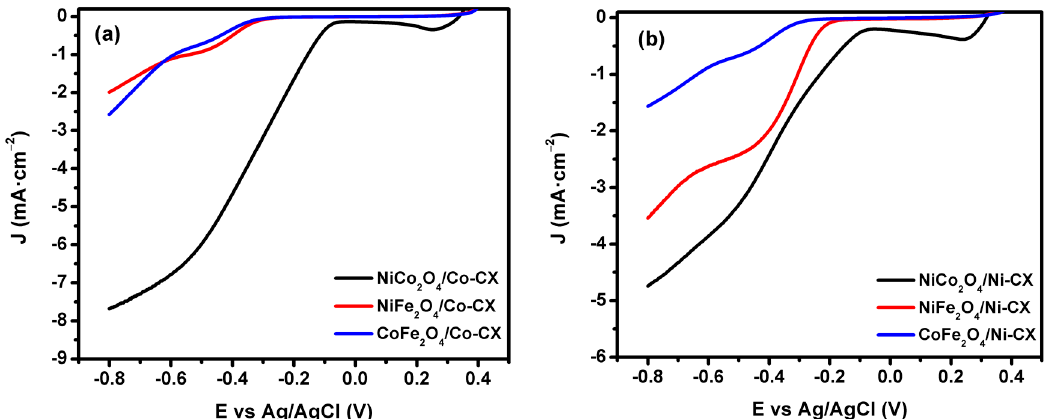
Figure 7. Linear sweep voltammograms (LSV) for ( a ) Co-CX and ( b ) Ni-CX doped with different bimetal oxides.